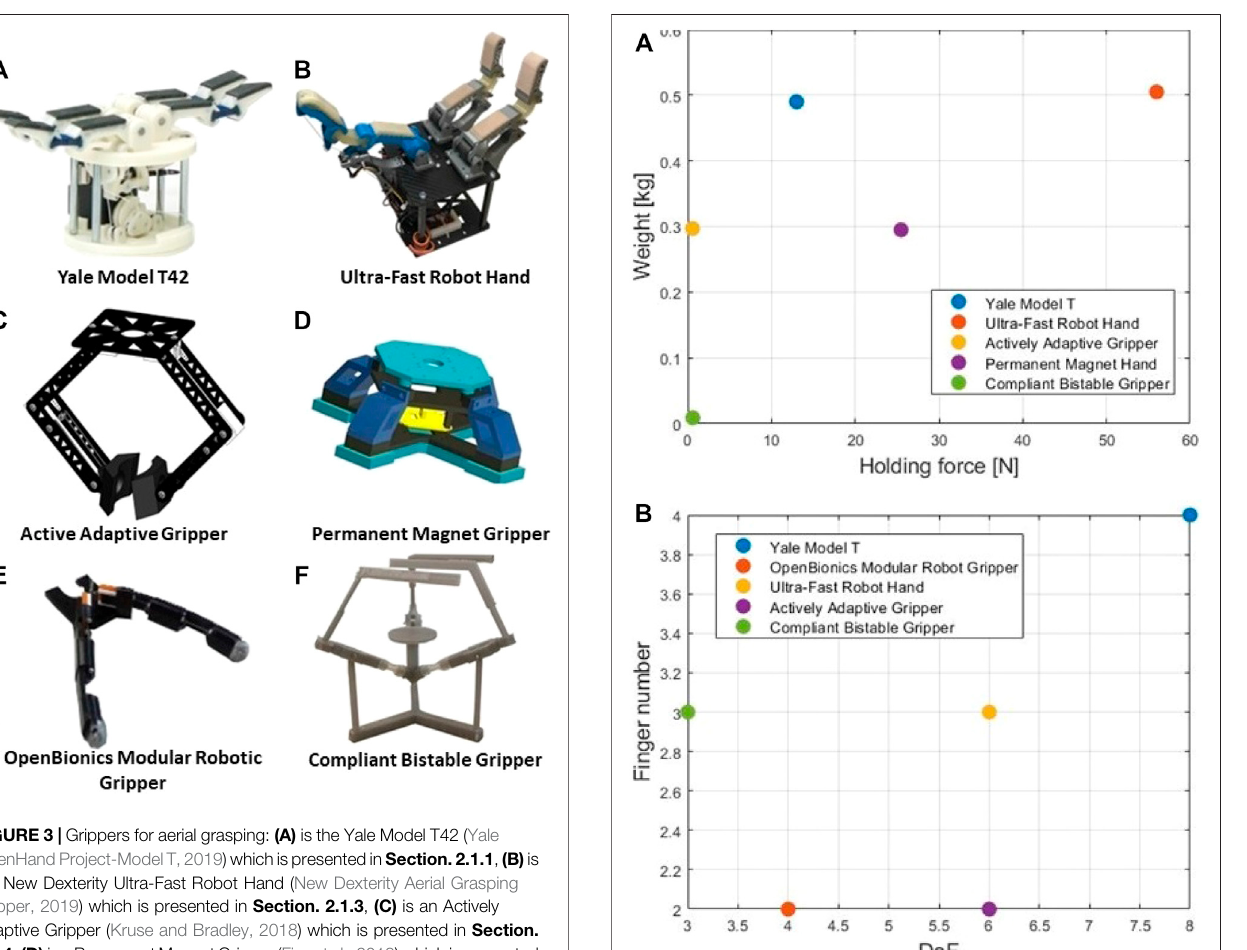
Frontiers in Robotics and AI |